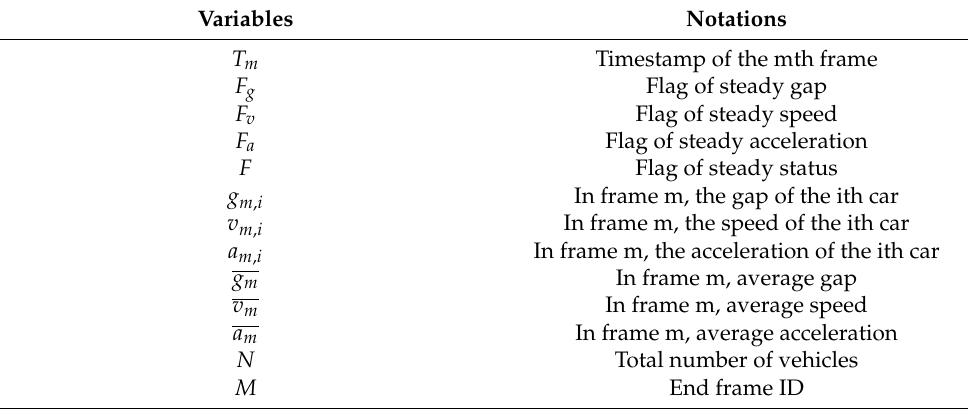
Figure 18. CACC test: ( a ) Top view of a CACC case, ( b ) Main view of a CACC case in VTD simulator. CarTest captures vehicle driving data and terminates the test when a stable vehicle formation is formed. This paper presents a way for evaluating the CACC algorithm’s merits. The Table 3 lists some of the parameters. Table 3. Notations of CACC evaluation